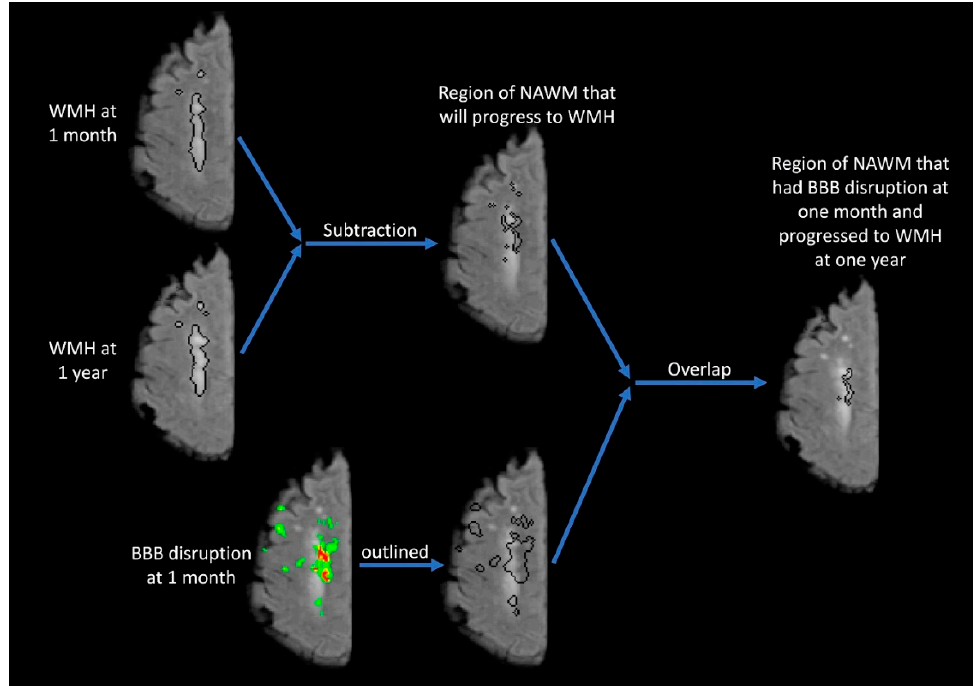
Figure 3. The purpose of this figure is to identify overlap between the location of BBB disruption 1 month after stroke and the locations of new white matter hyperintensities (WMH) at 1 year after stroke. The WMH region of interest (ROI) from 1 month is subtracted from the ROI at 1 year to identify regions of new WMH that are then superimposed on the 1-month FLAIR. Thus, the new ROI is an area of normal appearing white matter (NAWM) from the 1-month time point that will progress to WMH at the 1-year time point. Below that, the BBB disruption from the 1-month time point is outlined to form an ROI. The overlap between the BBB ROI and the ROI of new WMH is then identified to create a final ROI that identifies WHM progression that was preceded by BBB disruption.